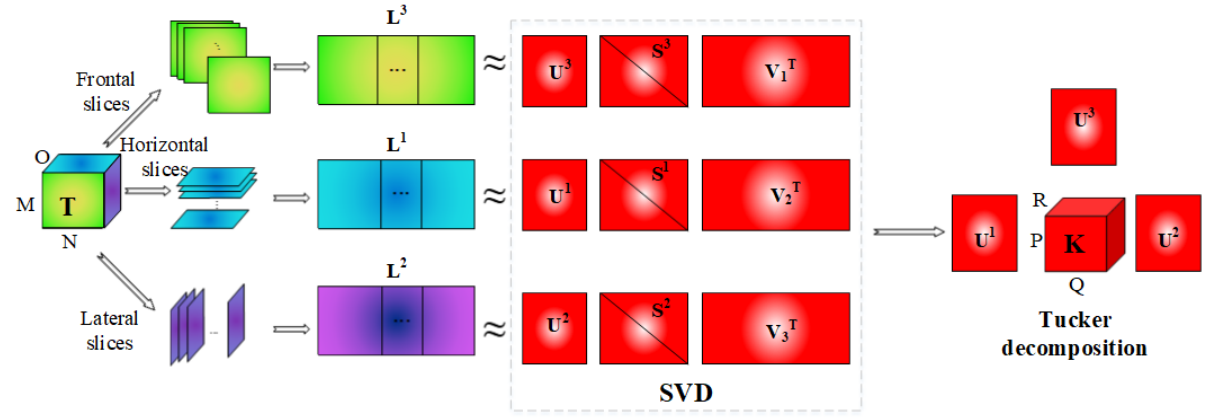
Figure 1. Tucker decomposition: a third-order tensor T decomposed by Tucker decomposition can obtain three orthogonal factor matrices U 1 , U 2 , U 3 , and a core tensor K